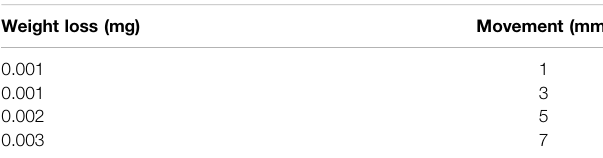
TABLE 5 | Abrasion test in nano fi brous egg shell waste material. Weight loss (mg)